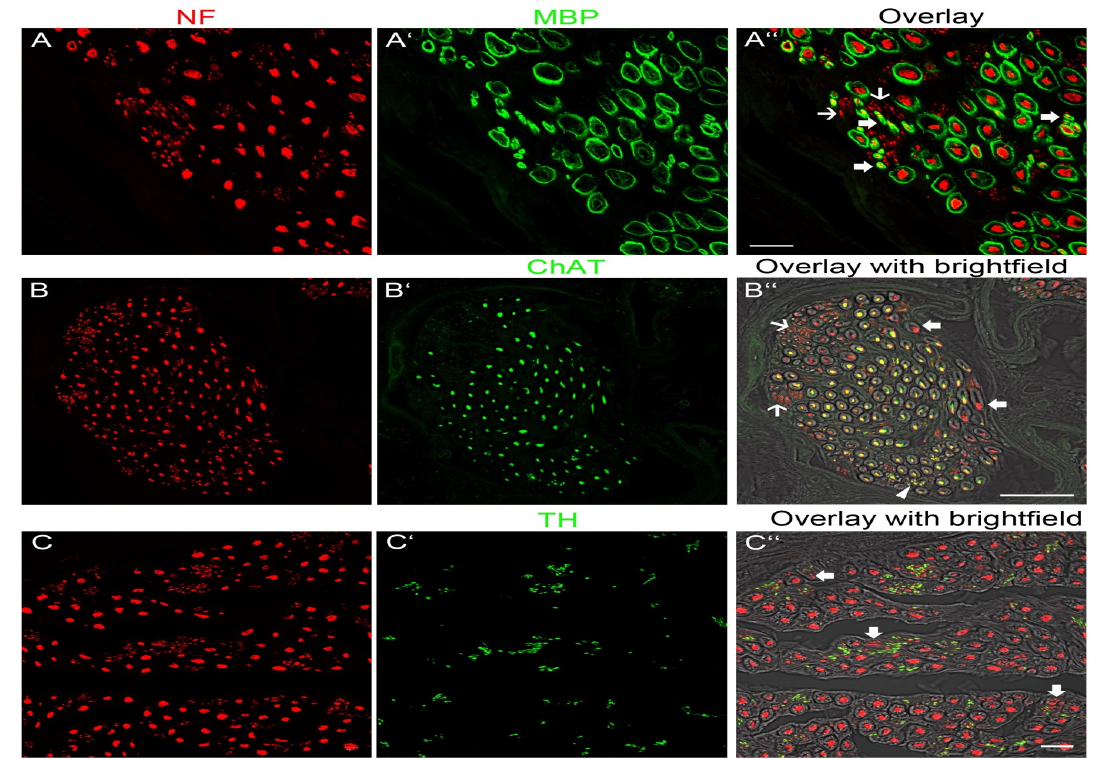
Figure 3. Fluorescence image showing the molecular profile of nerves innervating muscles of the lower extremity. ( A – A” ) Double labelling with anti-NF (red) and anti-MBP (green), a marker for myelin. ( A ) Showing axons in NF staining and ( B ) the myelin sheath in MBP staining. ( C ) Overlay visualising that large axons and thin axons (large arrows) are covered by a myelin sheath. Other thin axons (small arrows) lack a myelin sheath. Scale bar, 20 µ m. ( B – B” ) Double labelling with anti-NF (red) and anti-ChAT (green), a marker for cholinergic axons. ( A ) Showing axons in NF and ( B ) in ChAT staining. ( C ) Overlay of fluorescence and bright field images. The bright field image shows the anatomical structure of the myelin sheath. Large myelinated axons and thinly myelinated axons (arrowhead) express ChAT. Other large myelinated axons (large arrows) lack ChAT immunoreactivitiy. Unmyelinated axons (thin arrows) lack ChAT. Scale bar, 50 µ m. ( C – C” ) Double labelling with anti-NF (red) and anti-TH (green), a marker for sympathetic axons. ( A ) Showing axons in NF and ( B ) in TH staining. ( C ) Overlay of fluorescence and bright field images. The myelin sheath is shown in the bright field image. All myelinated axons and a few unmyelinated axons (arrows) lack TH immunoreactivity. The vast majority of unmyelinated axons express TH. Scale bar, 20 µ